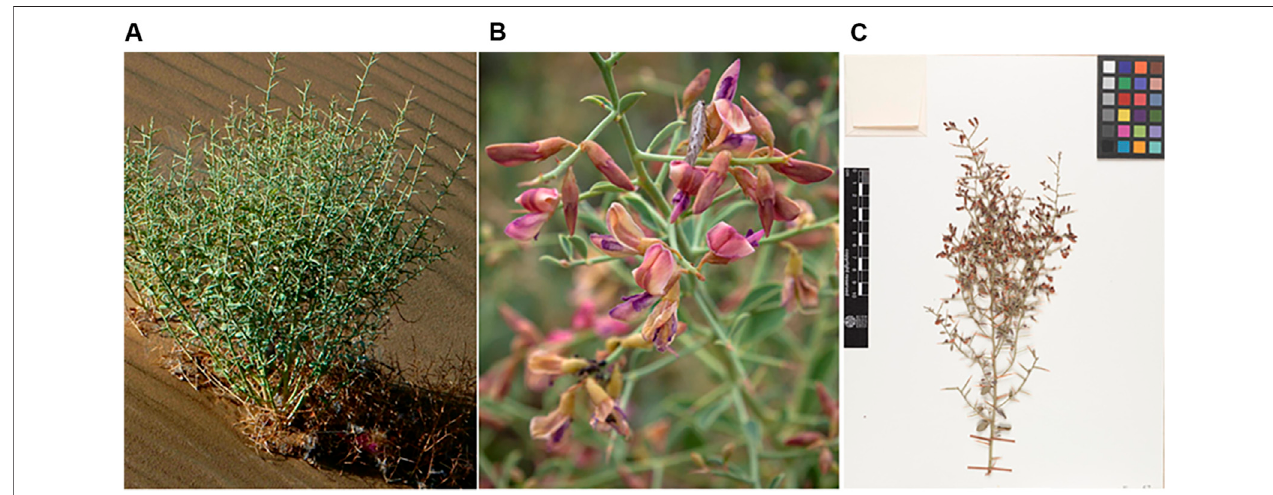
FIGURE 1 | The fi gure shows the habitat (A) , fl owers (B) and plant specimen (C) of A. sparsifolia ( (A) : http://ppbc.iplant.cn/tu/5783326, (B) : https://www. inaturalist.org/photos/43301374, (C) : http://data.rbge.org.uk/herb/E00364493).